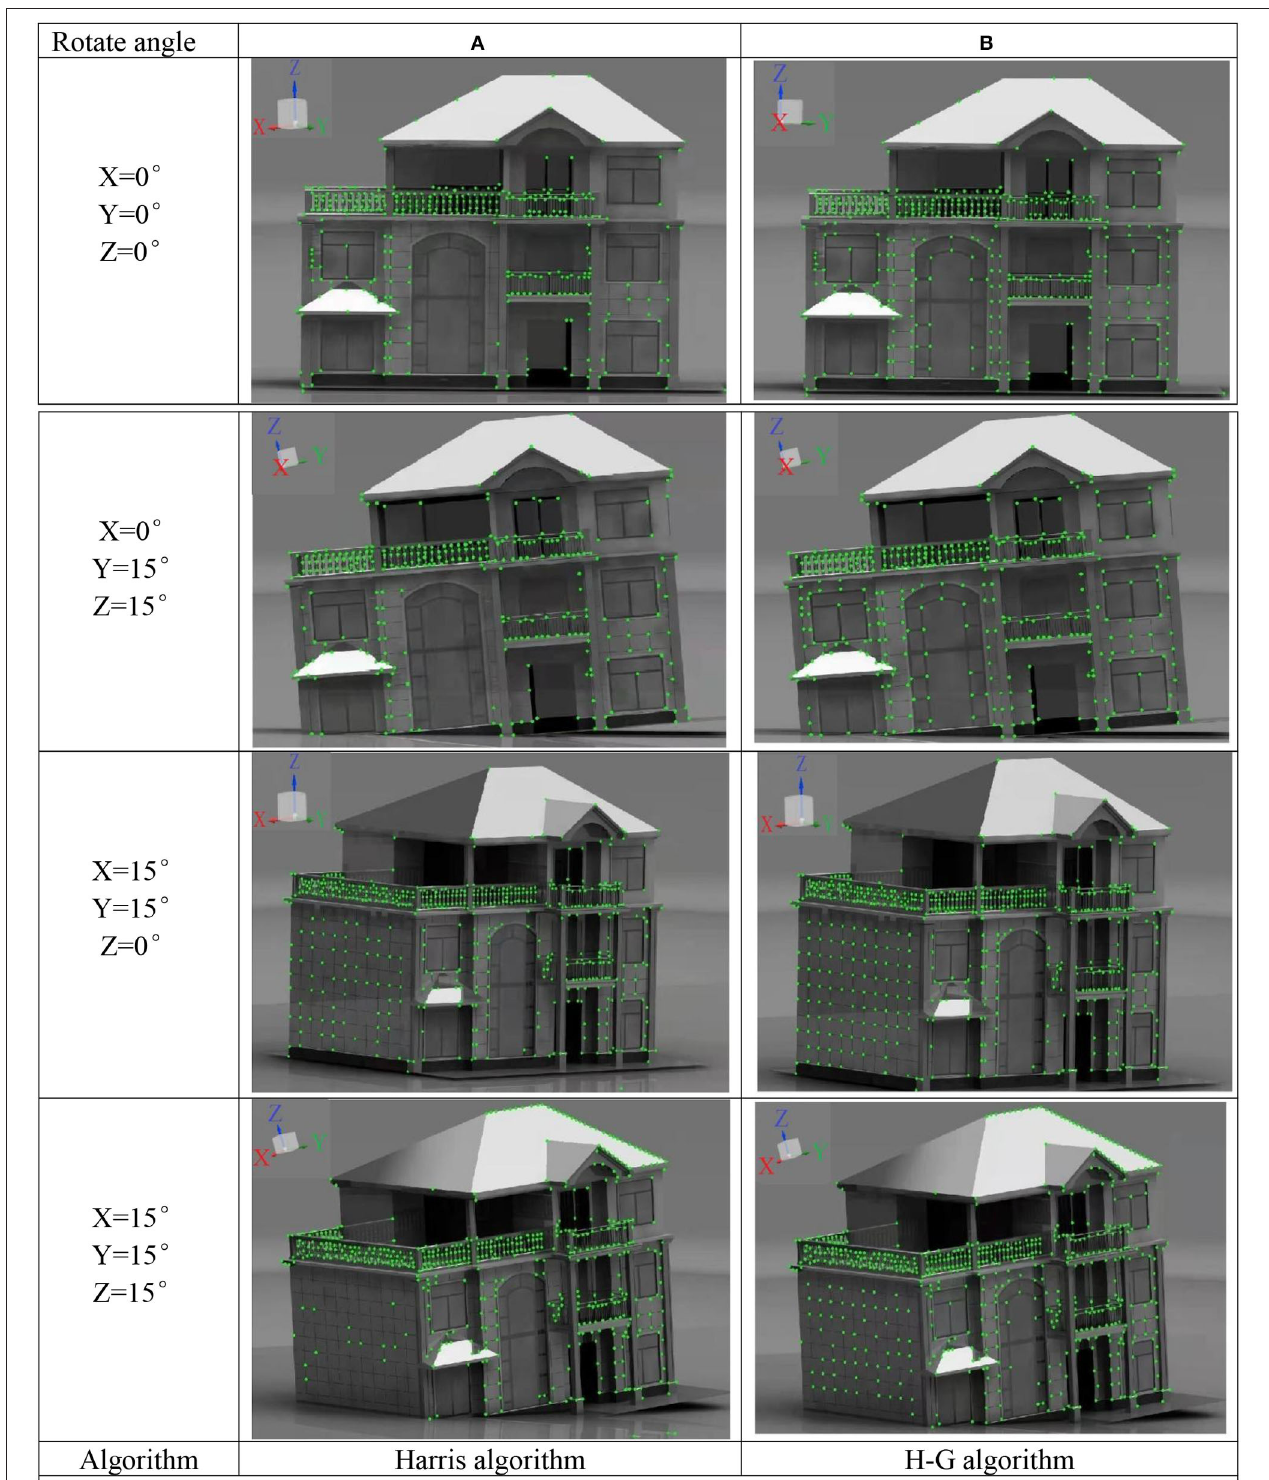
FIGURE 7 | Comparison of corner point detection results before and after improvement. (A) Results of corner detection by Harris algorithm. (B) Results of corner detection by H-G algorithm.